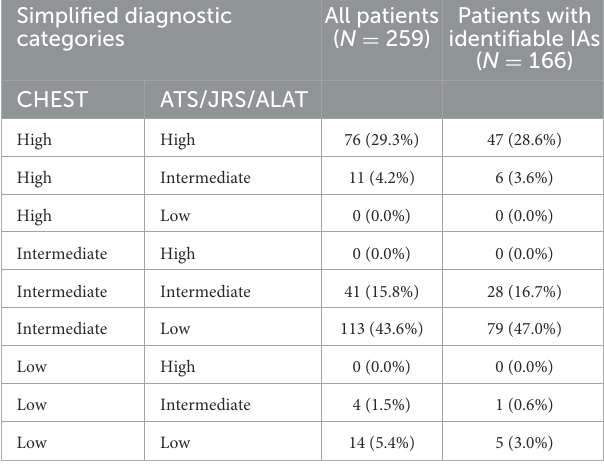
TABLE 3 Comparison of diagnostic confidence based on the CHEST guideline with that based on the ATS/JRS/ALAT guideline in all patients and those with identifiable inciting agents